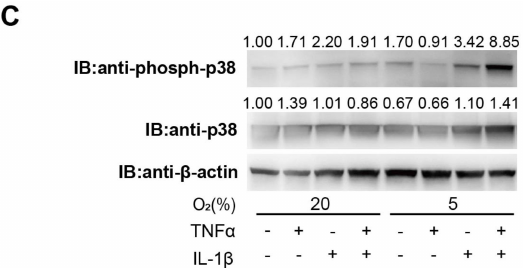
Figure 3. Involvement of PI3K and MAPK signaling pathways in cytokine-induced HIF-1 activation. ( A ) EM-E6/E7/TERT cells were exposed to TNF α (500 ng/mL) and IL-1 β (100 ng/mL) with or without the indicated kinase inhibitors (25 µ mol/L LY, 20 µ mol/L PD, and 100 µ mol/L SC) or 10 mM N-acetyl-L-cysteine (NAC) for 6 h under 20% O 2 conditions, and whole-cell lysates were immunoblotted for HIF-1 α and β -actin. LY—LY294002; PD—PD98059; SC—SC-514. ( B , C ) EM- E6/E7/TERT cells were exposed to culture media (–), TNF α (500 ng/mL), and IL-1 β (100 ng/mL) under 20% or 5% O 2 conditions for 6 h. After the treatment, whole-cell lysates were immunoblotted for phospho-ERK1/2, ERK1/2 ( B ), phospho-p38, p38 ( C ), and β -actin. ( A – C ) The densitometric analysis’ findings, normalized by - β actin, are displayed as the values above the